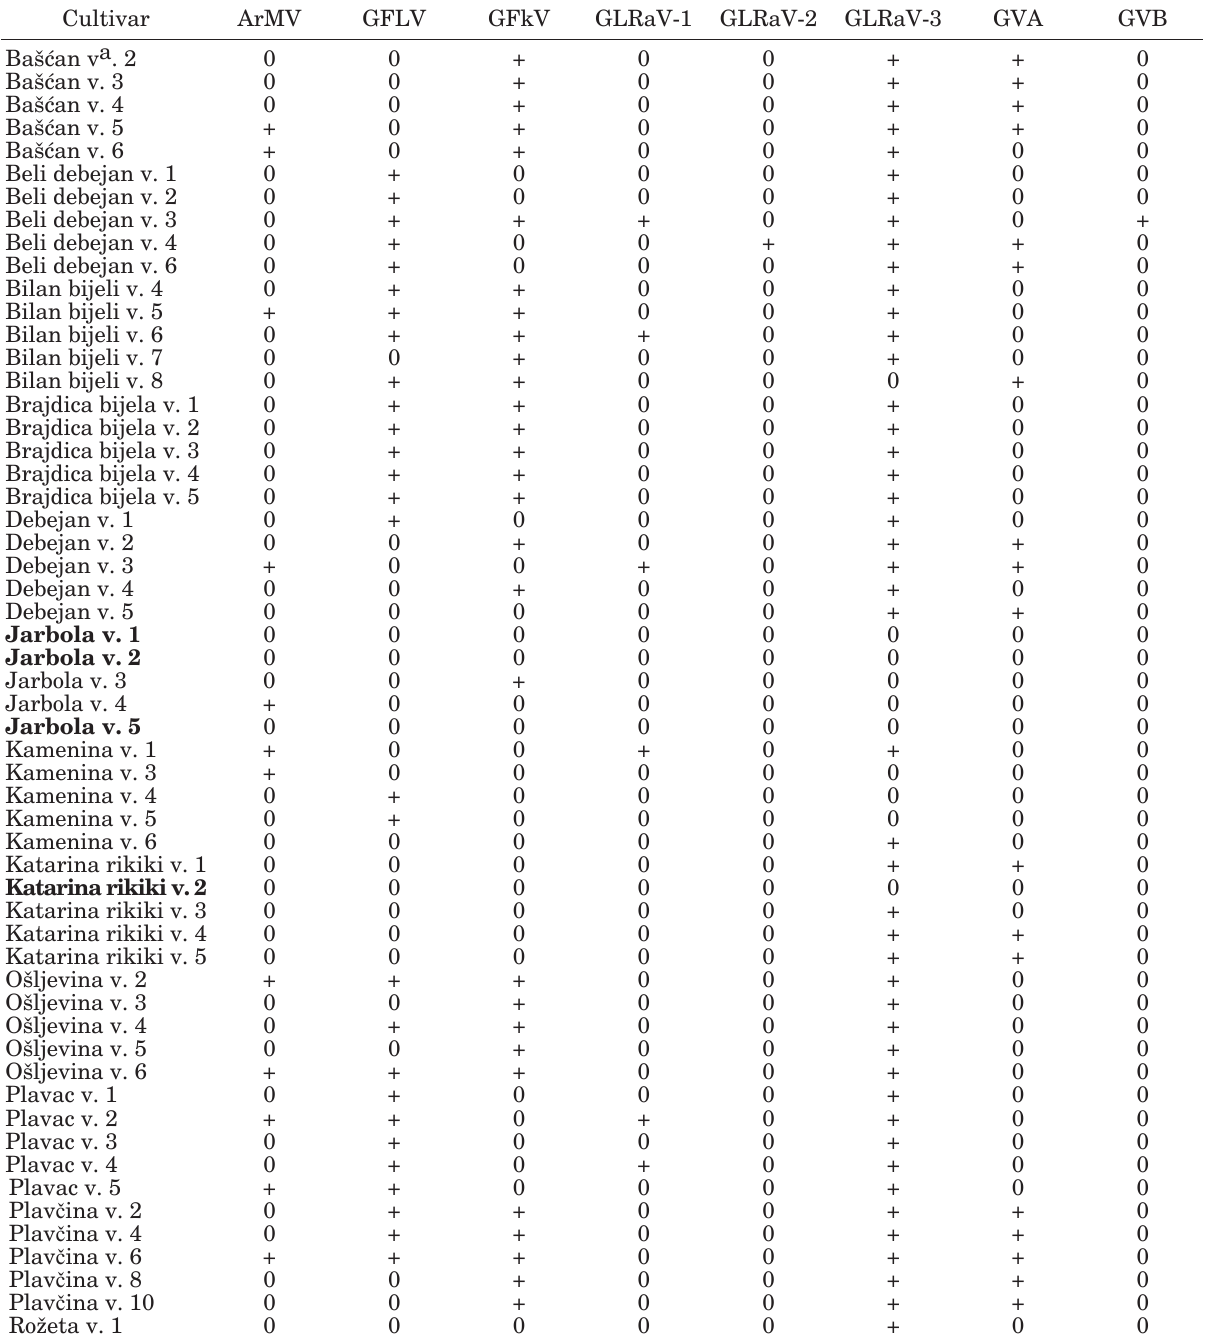
Table 2. Incidence of virus infections determined by ELISA, test in the regional Risika collection of Croatian native grape varieties. ArMV - Arabis mosaic virus , GFLV - Grapevine fanleaf virus , GFkV - Grapevine fl eck virus , GLRaV-1 - Grapevine leafroll-associated virus 1 , GLRaV-2 - Grapevine leafroll-associated virus 2 , GLRaV-3 - Grapevine leafroll- associated virus 3 , GVA - Grapevine virus A and GVB - Grapevine virus B . Cultivars in bold were free of all eight tested